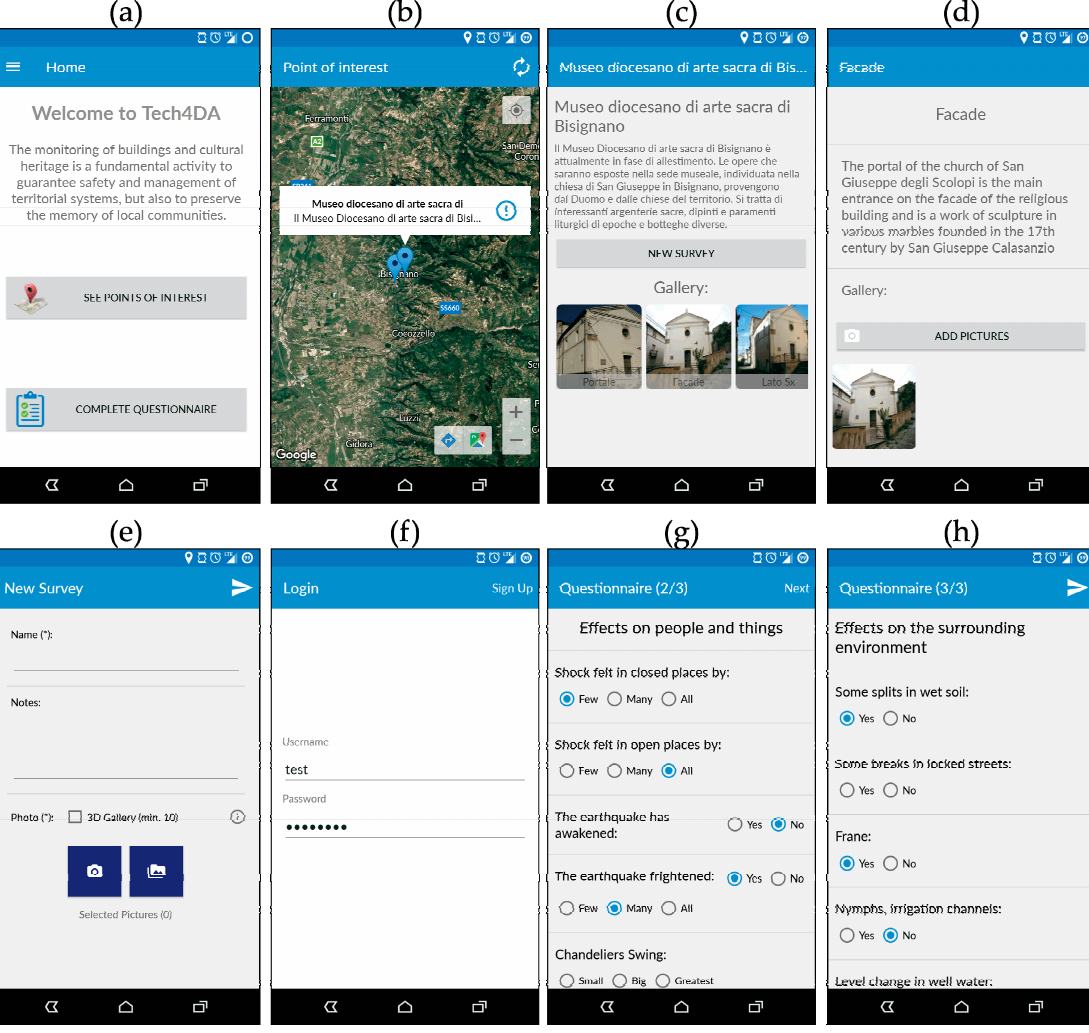
Figure 2. Mobile application: homepage ( a ); points of interest (POI) on map viewer ( b ); page of POI details ( c ); details about an existent photo gallery ( d ); page to acquire a new survey ( e ); login form ( f ); questionnaire pages about the effect due to an earthquake on people ( g ) and environment ( h